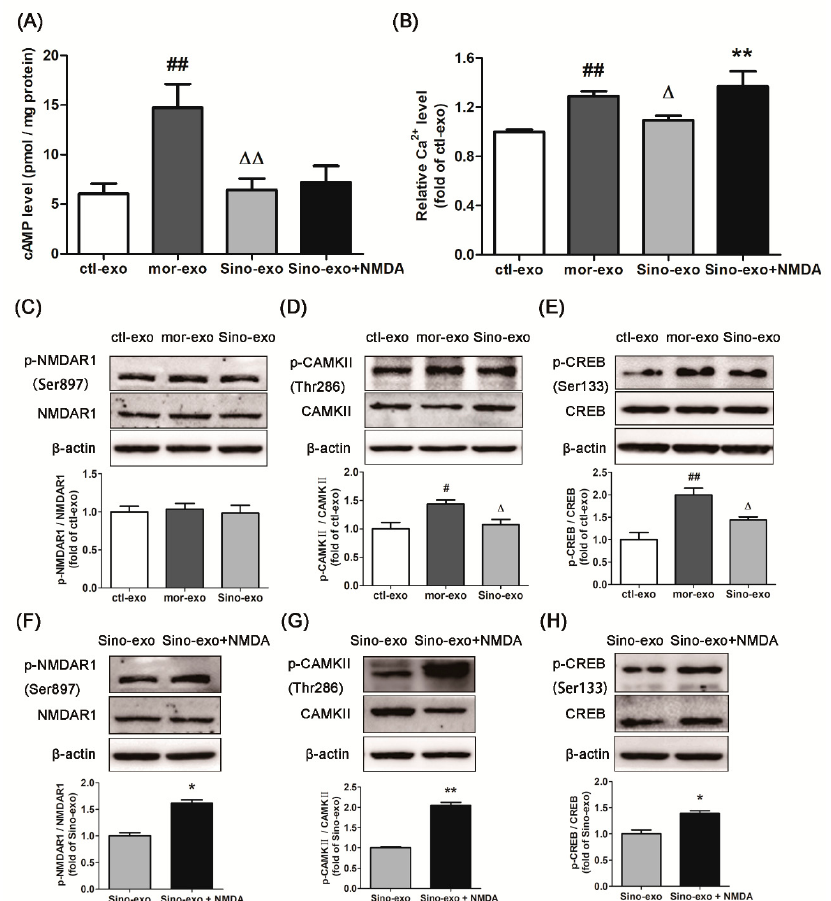
Figure 6. Effects of astrocyte-derived exosomes on morphine-treated SH-SY5Y cells and subsequent intervention by sinomenine. ( A ) Sino-exo decreased the level of cAMP induced by mor-exo in the morphine-treated SH-SY5Y cells ( n = 3); ( B ) Sino-exodecreased the level of intracellular Ca 2+ induced by mor-exo in the morphine-treated SH-SY5Y cells ( n = 3); ( C – E ) Effects of Sino-exo on p-NMDAR1/NMDAR1, p-CAMKII/CAMKII, and p-CREB/CREB induced by mor-exo in the morphine-treated SH-SY5Y cells ( n = 3); ( F – H ) NMDAR agonist reversed the inhibitory effect of Sino-exo on p-NMDAR1/NMDAR1, p-CAMKII/CAMKII, and p-CREB/CREB ( n = 3). Ctl-exo: exosomes extracted from cultured primary astrocytes; mor-exo: exosomes extracted from cultured primary astrocytes treated with 100 μ M morphine for 48 h; Sino-exo: exosomes extracted from cultured primary astrocytes treated with 100 μ M morphine and 200 μ Msinomenine for 48 h. # p < 0.05, ## p < 0.01 vs. ctl-exo; Δ p < 0.05, ΔΔ p < 0.01 vs. mor-exo; * p < 0.05, ** p < 0.01 vs. Sino-exo.